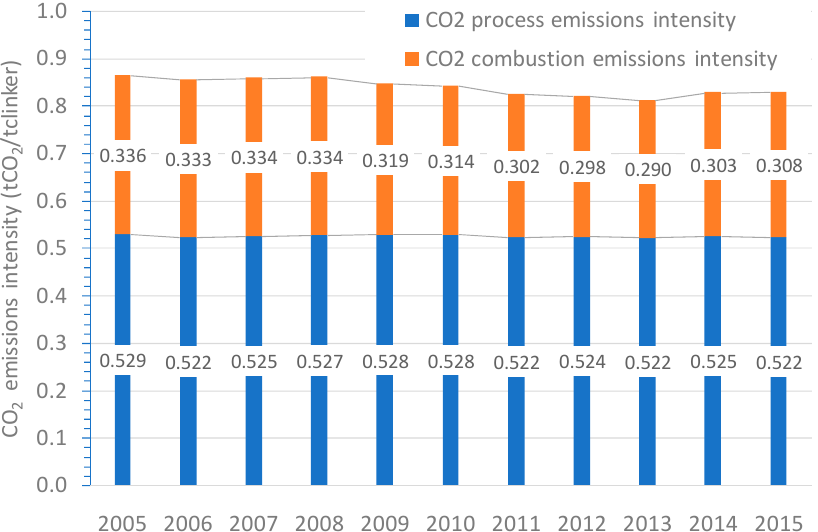
Figure 12. CO 2 global emissions intensity (t CO2 / t clinker ). Evolution from 2005 to 2015 of the Spanish clinker production.